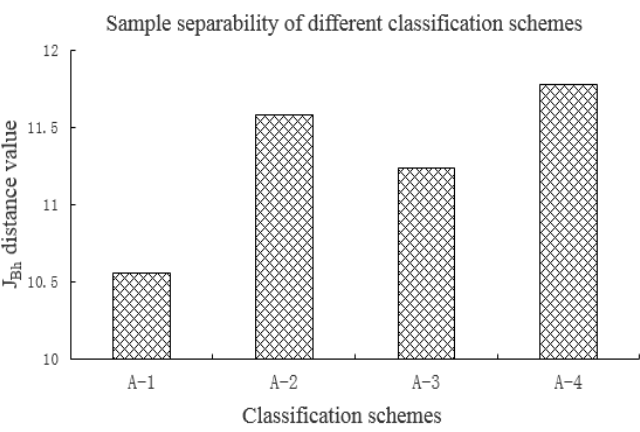
Figure 3. J Bh distance of different spectral classification schemes for GF-6 WFV data.